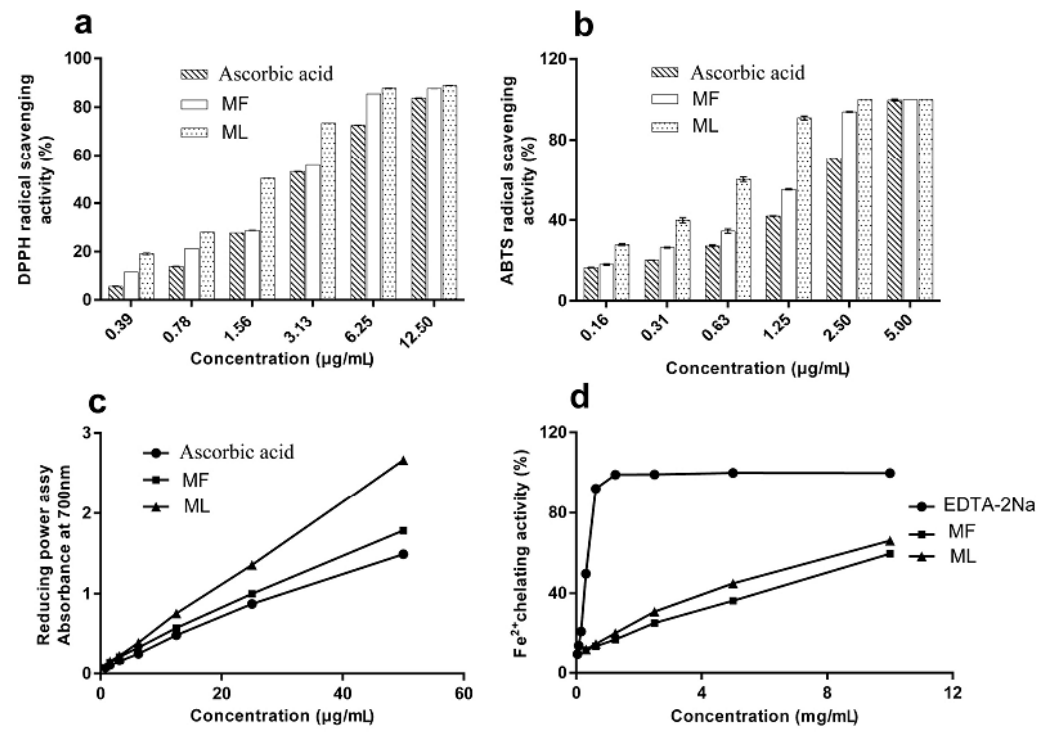
Figure 1. Determination of the antioxidant activities of extracts from Paeonia rockii leaves and flowers using ( a ) DPPH radical scavenging assay; ( b ) ABTS radical scavenging assay; ( c ) reducing power